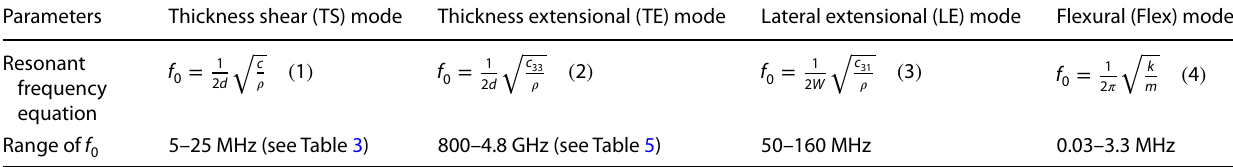
Table 2 Resonant frequency equations and their range for the four different modes of the piezoelectric vibration based on bulk acoustic waves